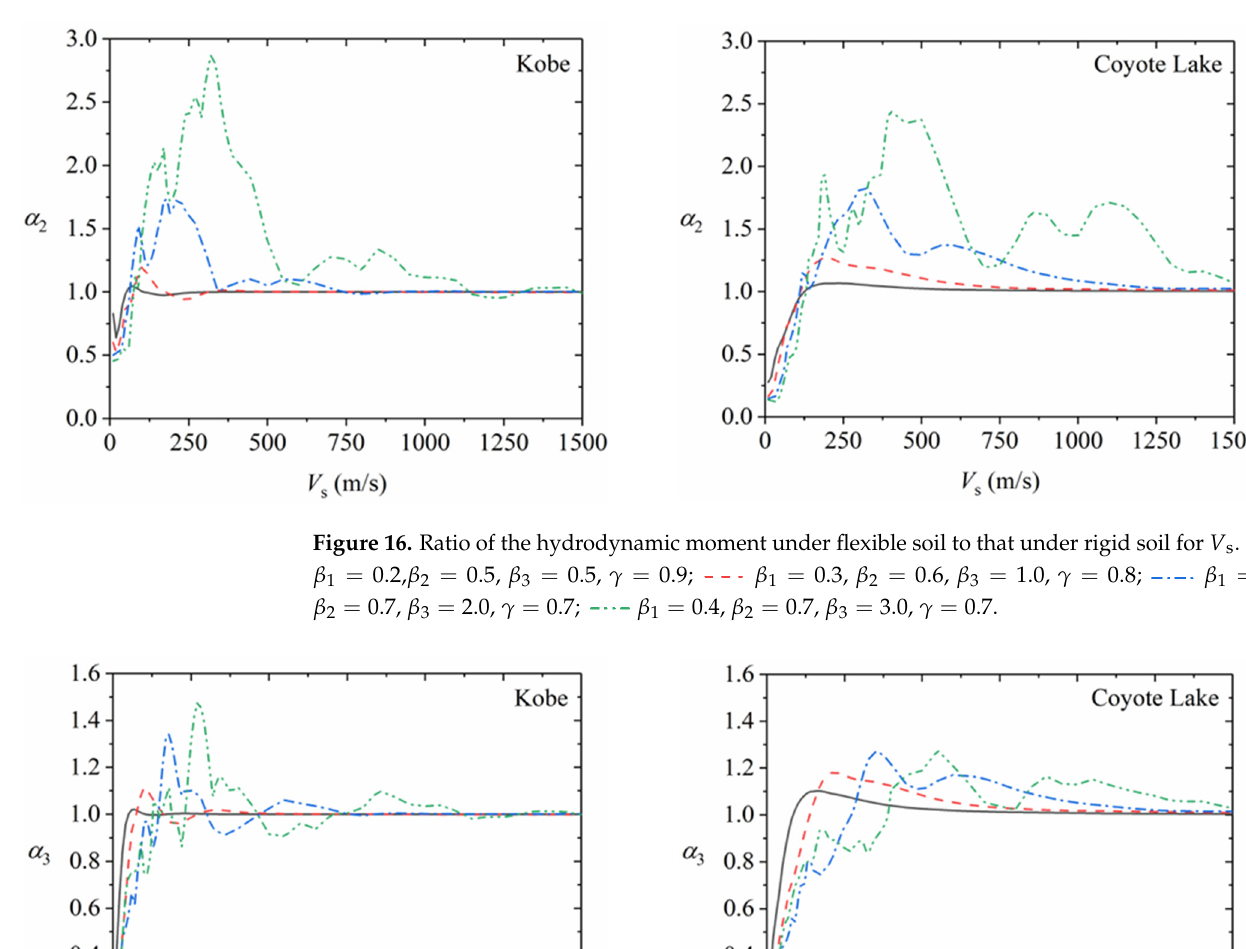
Figure 15. Ratio of the hydrodynamic shear under flexible soil to that under rigid soil for V s .